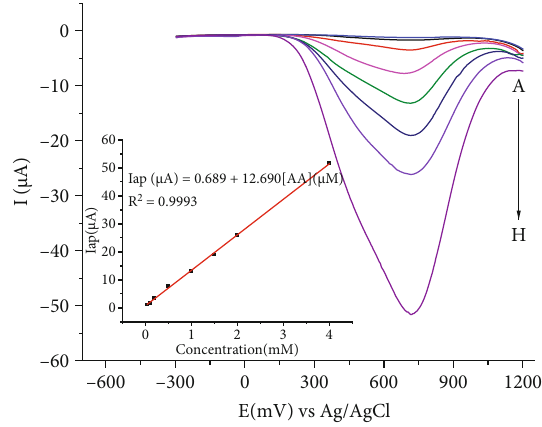
Figure 9: SWVs of extracts of cabbage sample from (a) Guld, (b) Karshewa, and (c) Birbira in pH 4.0 PBS at 30mV amplitude, 7 mV step potential, and 35Hz frequency. Inset: plot of anodic peak current vs. sample area.